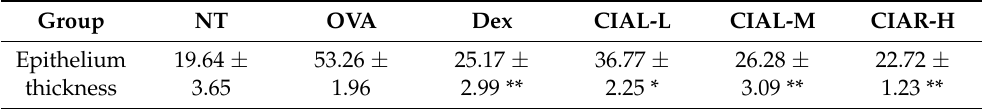
Table 1. The values for the thickness of the respiratory epithelium in OVA-induced mice. Group NT OVA Dex CIAL-L CIAR-H Epithelium thickness